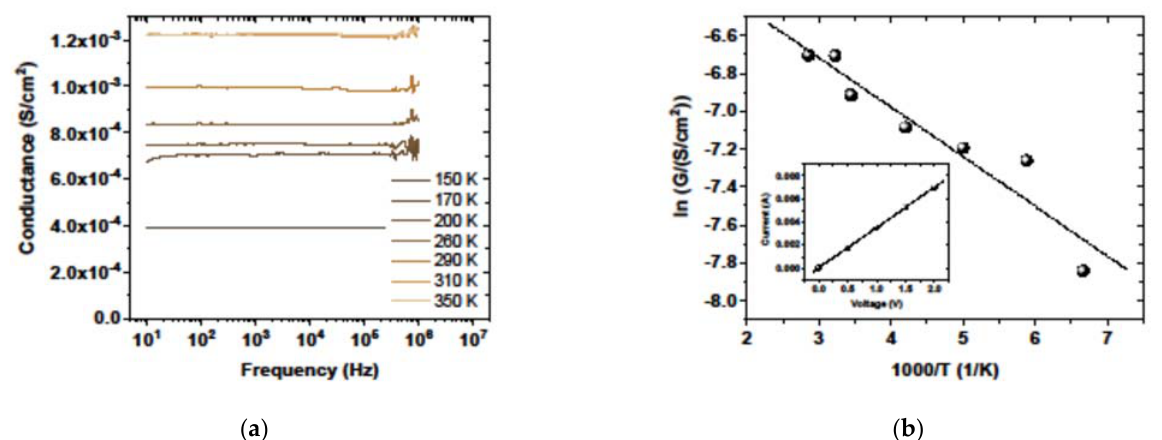
Figure 7. Admittance measurement results: Frequency dependence of sample conductivity at different temperatures ( a ) and the Arrhenius diagram of the logarithm of conductivity versus inverse temperature ( b ) (inset—current ‐ voltage measurements indicating an ohmic contact to the sample).